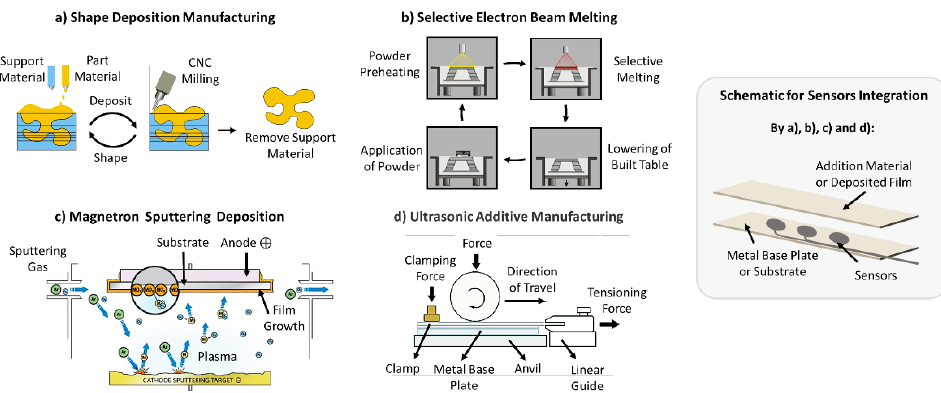
Figure 11. Methodology for sensor integration into metal components.